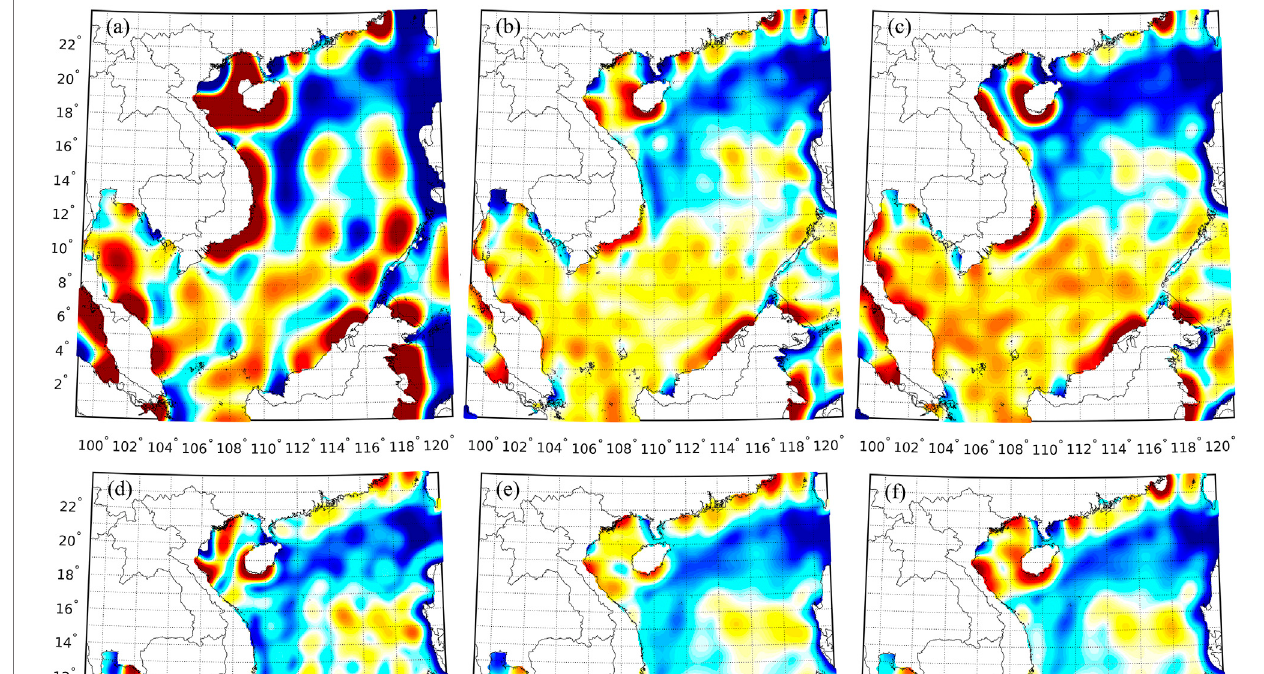
Frontiers in Earth Science |